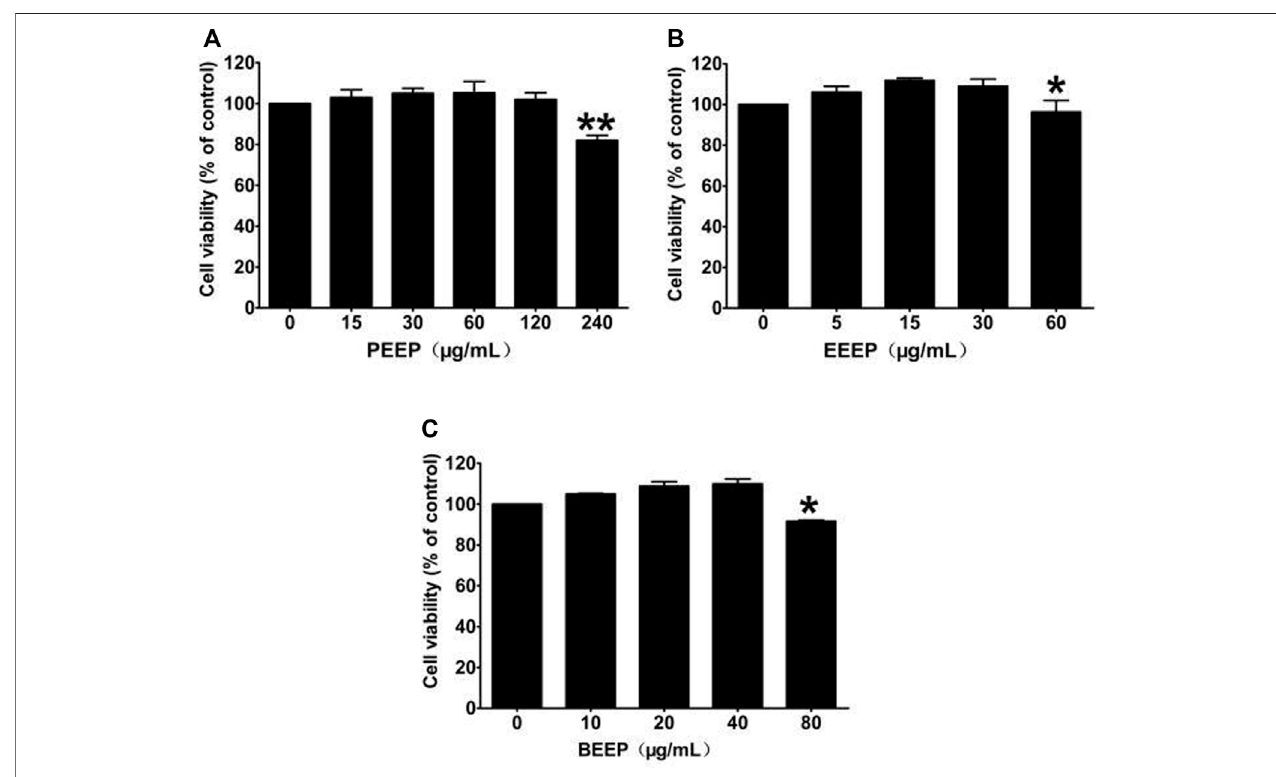
FIGURE1| Effectsofdifferent concentrationsofPEEP, EEEP, and BEEP on cellviabilityin RAW264.7 cells. Results wereexhibitedasthe means± S.E.M. ofthree independent experiments. * p < 0.05, ** p < 0.01 vs. Normal